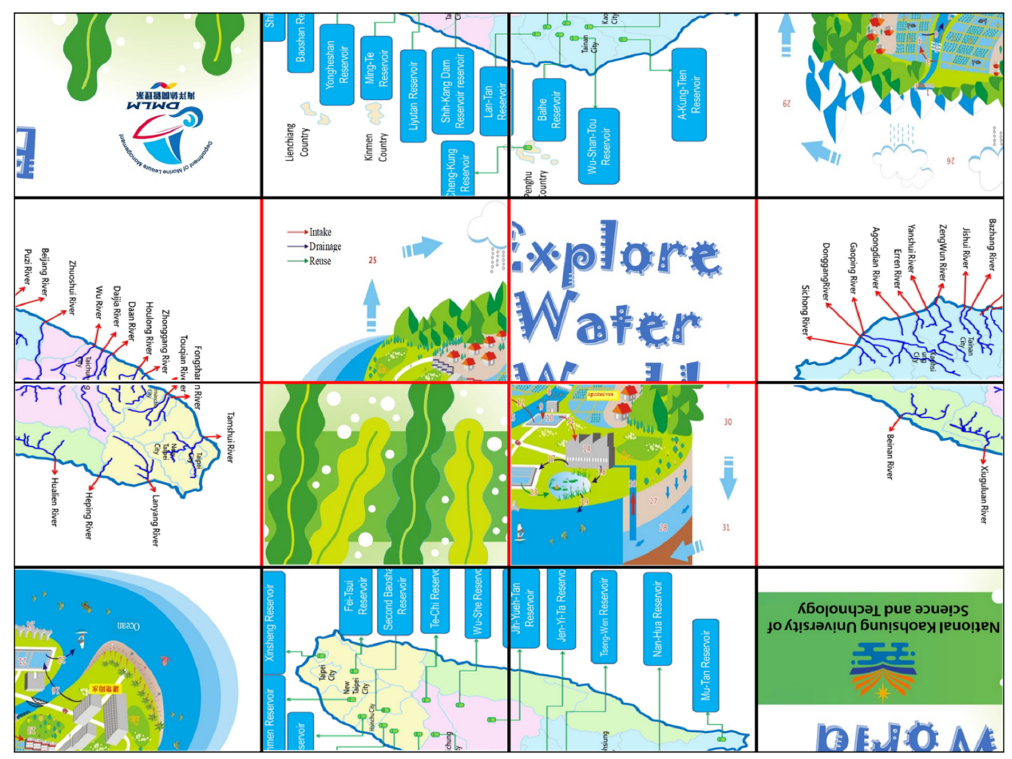
Figure 2. Jigsaw